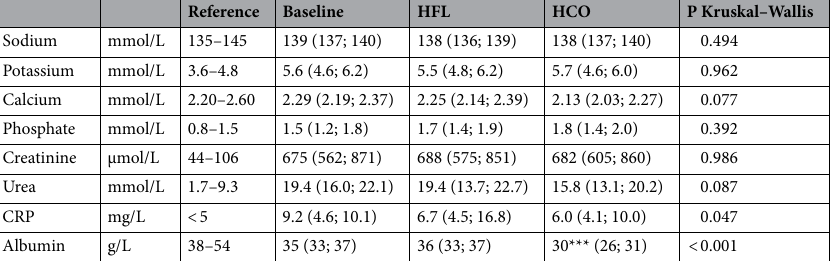
Table 1. Clinical chemistry at baseline and after 3 weeks of HFL and HCO dialysis. Blood samples were collected pre-dialysis at the first dialysis session of experimental phase 1 (baseline) and pre-dialysis at the first dialysis session after completion of both 3-week experimental phases (HFL, HCO). Median (25% percentile; 75% percentile), n = 19, *** P < 0.001 HCO versus Baseline and HCO versus